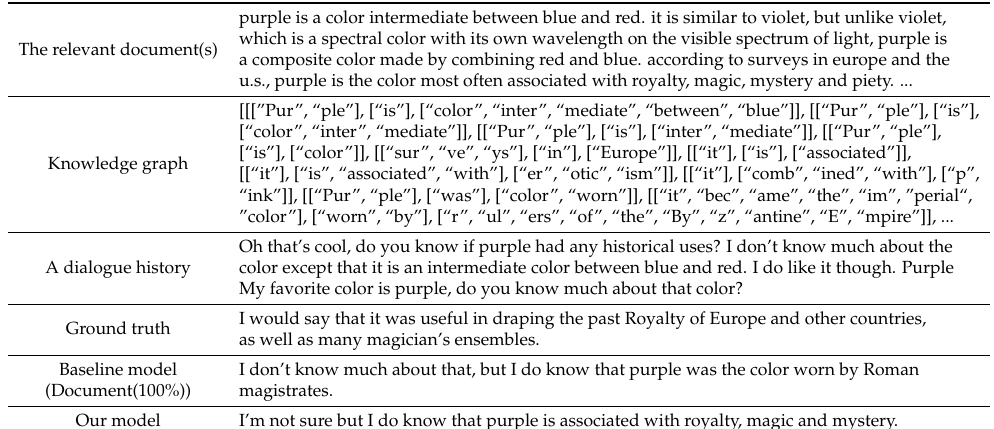
Table 7. An example of the response on the Wizard-of-Wikipedia